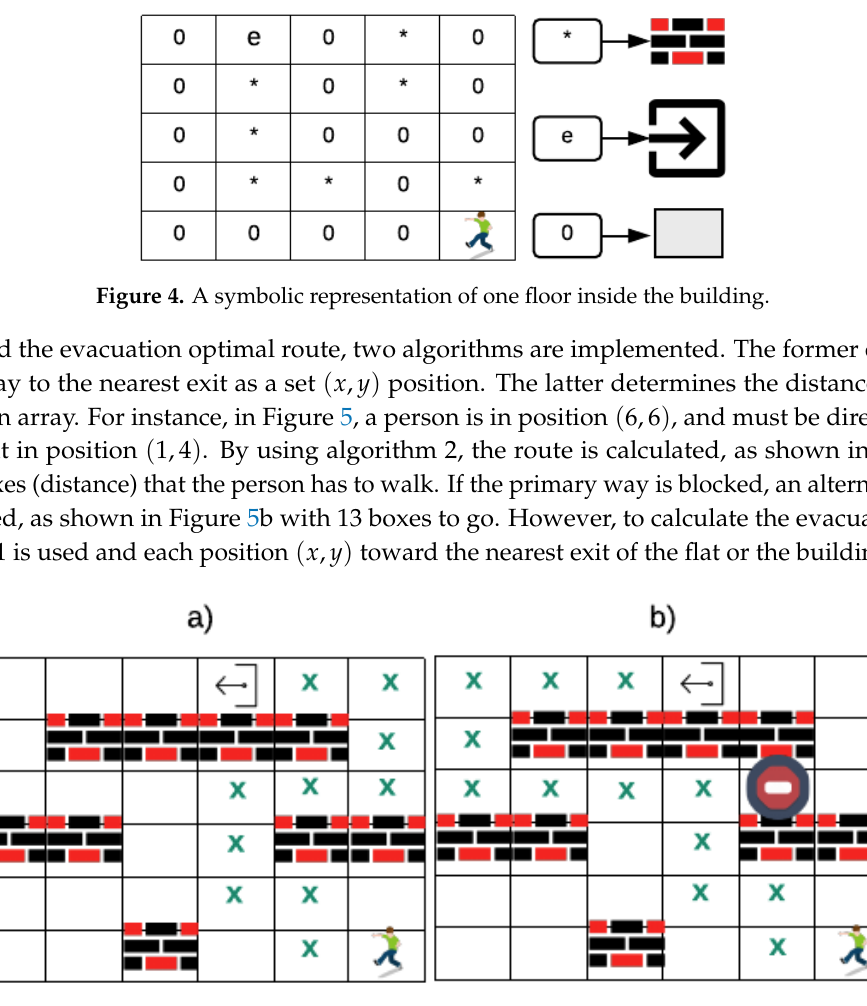
Figure 5. Evacuation route in a matrix using Breadth-First Search (BFS): ( a ) Non-blocked; ( b )